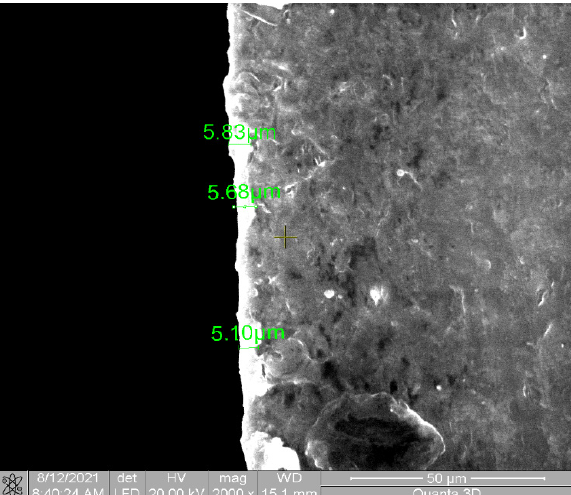
Figure 9. SEM of cross-sectioned granule of Ag-coated